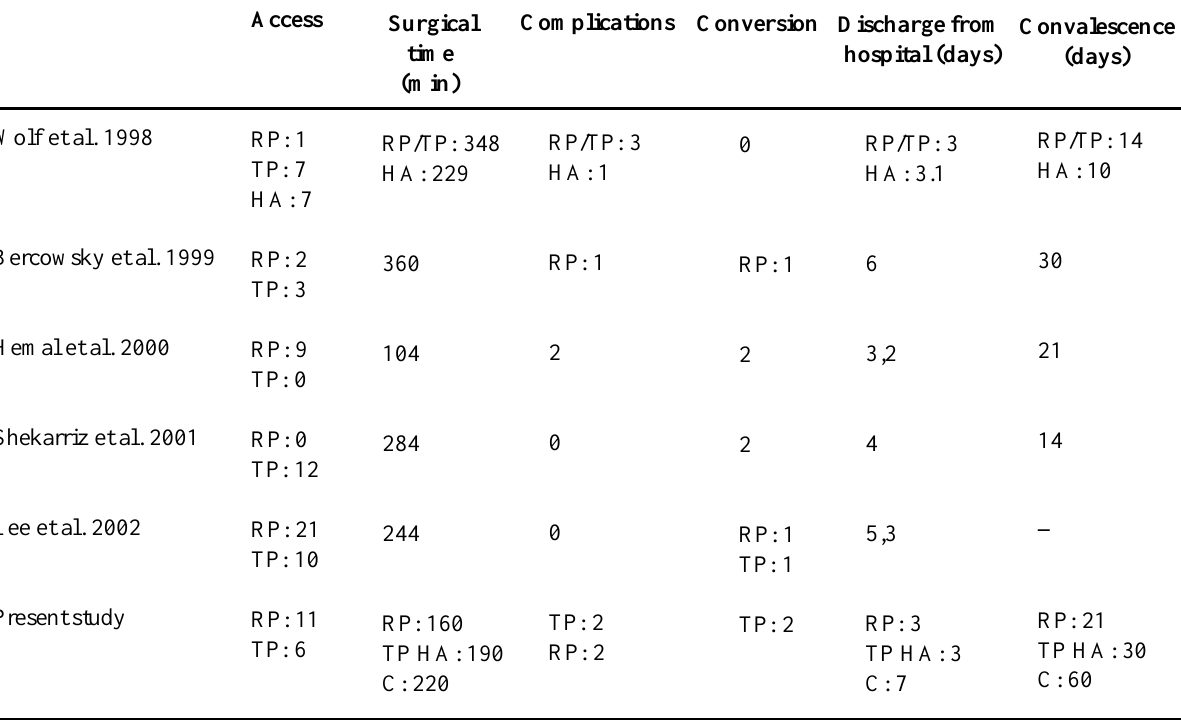
Table 2 – Comparison between results of works describing series of laparoscopic nephrectomy for inflammatory